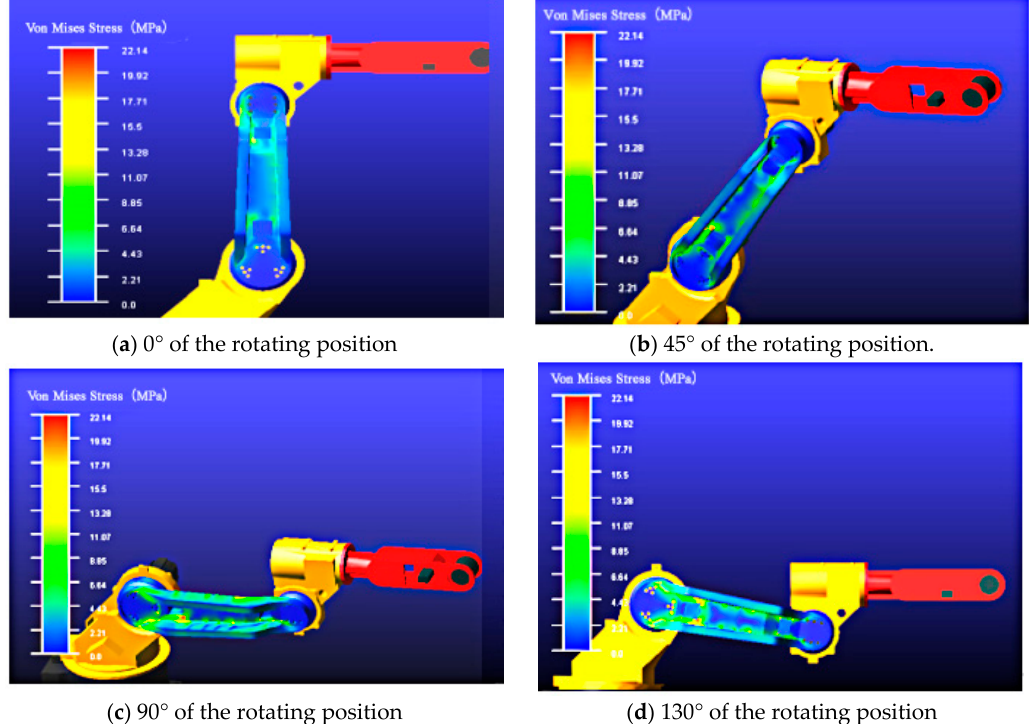
Figure 8. Simulation of the upper arm at different positions, ( a ) 0° of the rotating position, ( b ) 45° of the rotating position, ( c ) 90° of the rotating position, ( d ) 130° of the rotating position.